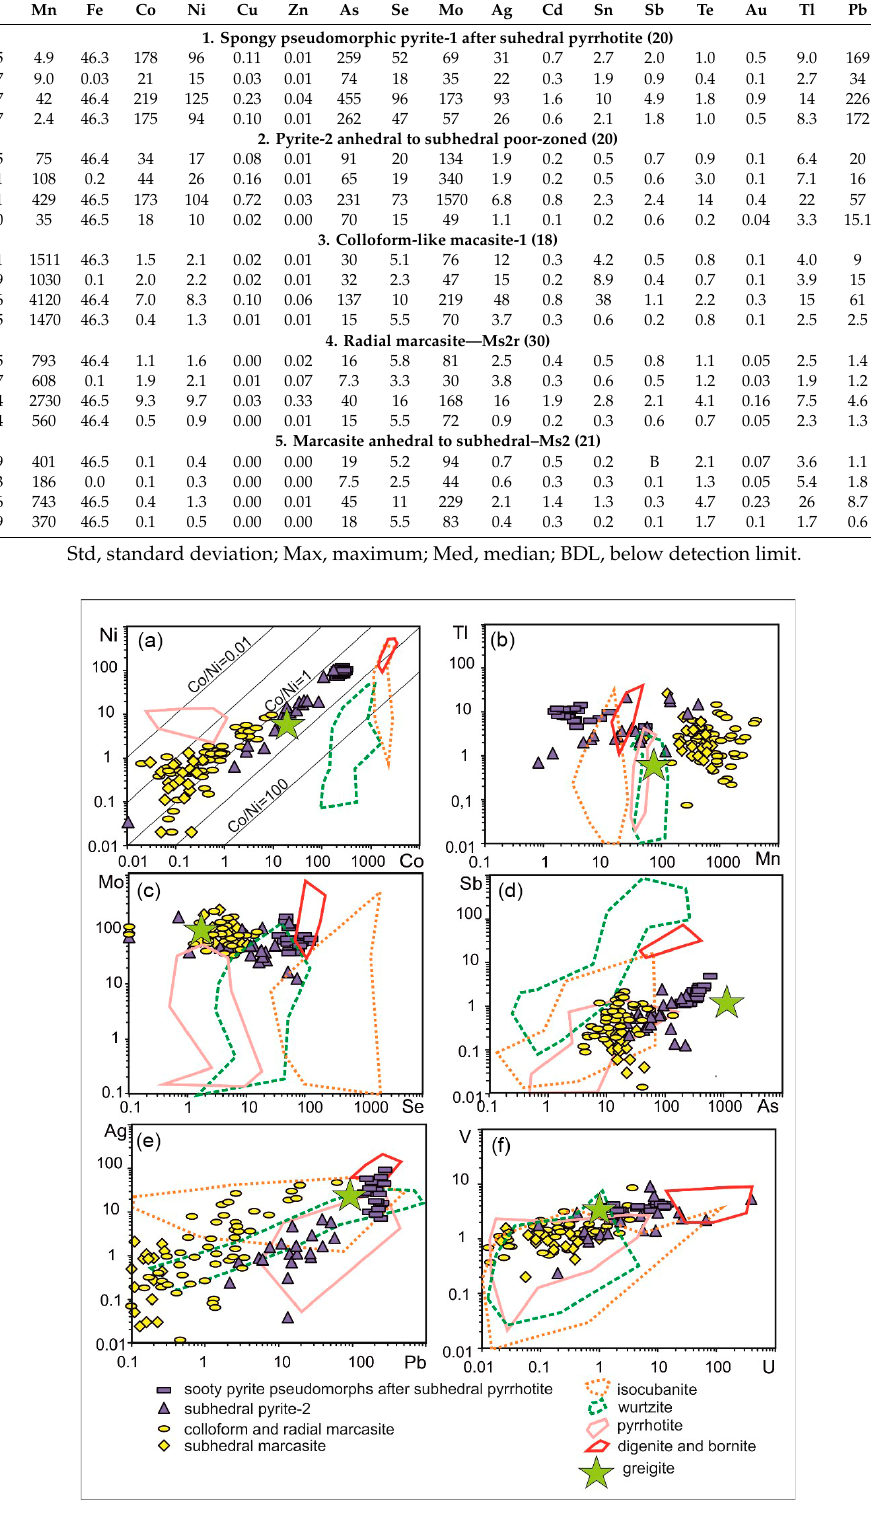
Figure 9. Diagrams of trace elements concentrations in sulfides of marcasite-pyrite crust (sample 37L-107-10). Pobeda-2 hydrothermal field. ( a ) Co vs Ni ratio; ( b ) Mn vs Tl ratio; ( c ) Se vs Mo ratio; ( d ) As vs Sb ratio; ( e ) Pb vs Ag ratio; ( f ) U vs V ratio.